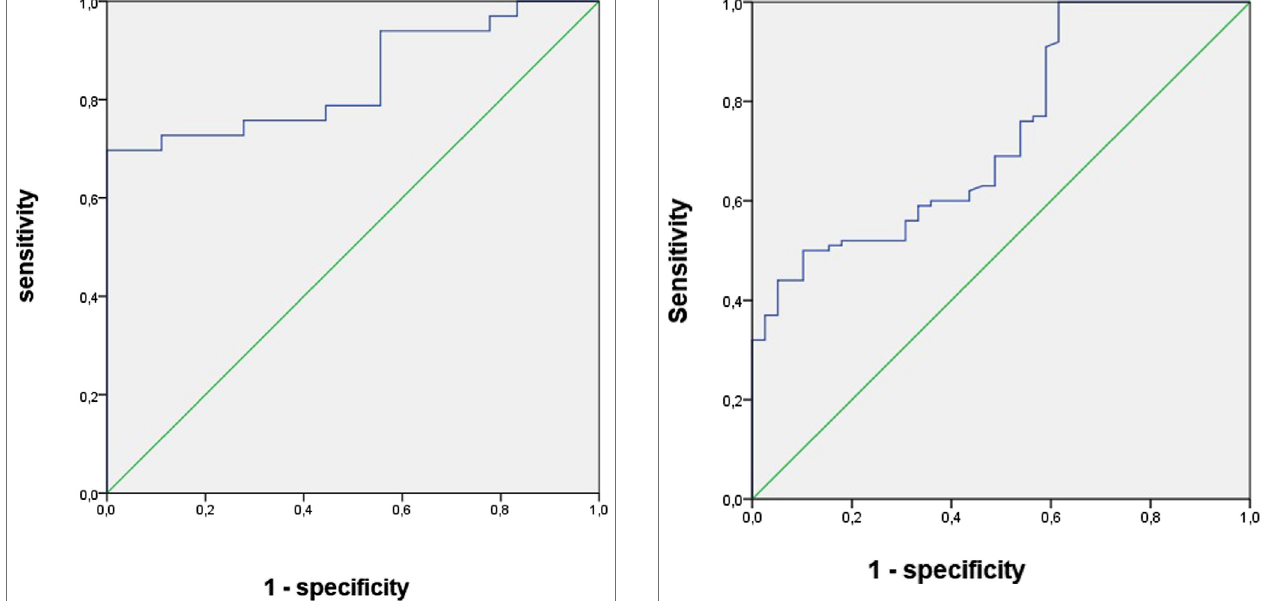
FIGURE2| Areaundercurveofvancomycinconcentrationaspredictors of acute kidney injury diagnosis in patients undergoing vancomycin and hospitalized in wards.